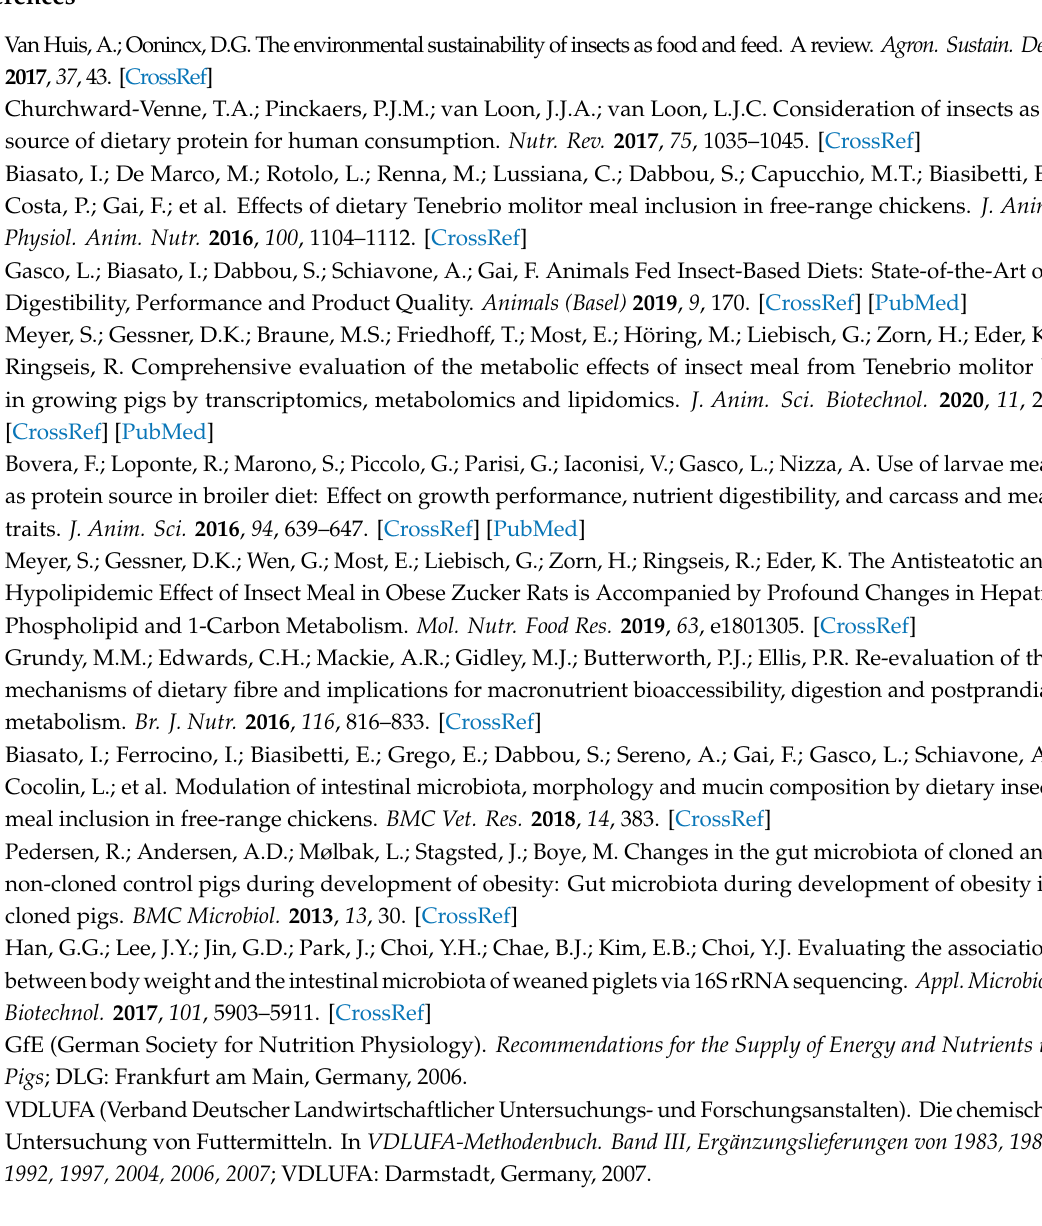
Table S1: Characteristics of gene-specific primers used for qPCR analysis in the small intestinal mucosa, Table S2: Operational taxonomic units (OUT) identified in cecum digesta of all experimental